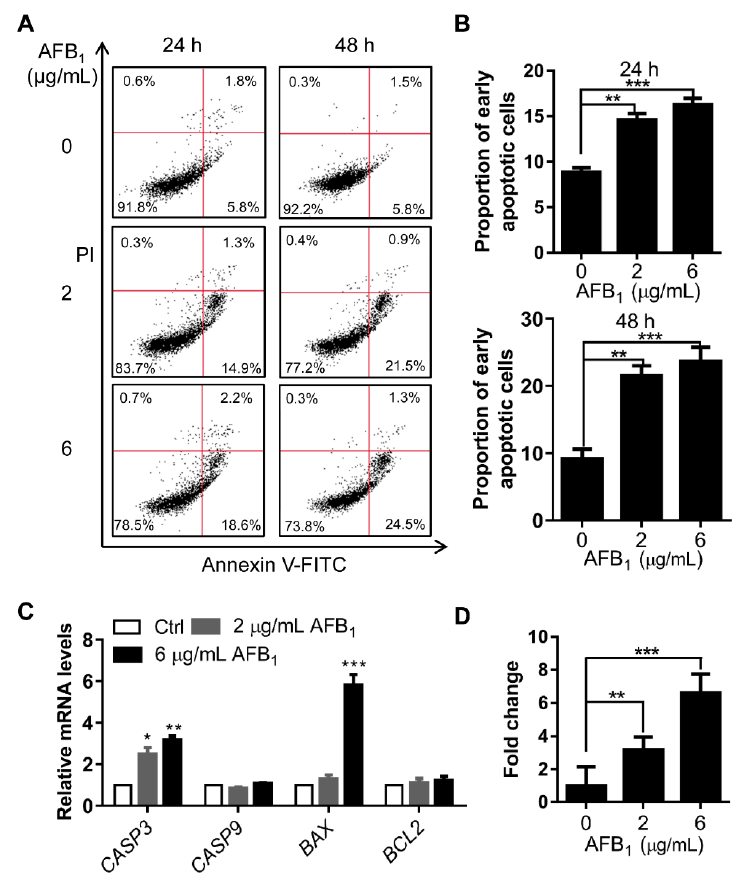
Figure 6. AFB 1 induces apoptosis in IMR-32 cells. ( A ) Apoptosis analysis of IMR-32 cells after AFB 1 treatment by flow cytometry. The data were analyzed with FlowJo software. ( B ) The proportion